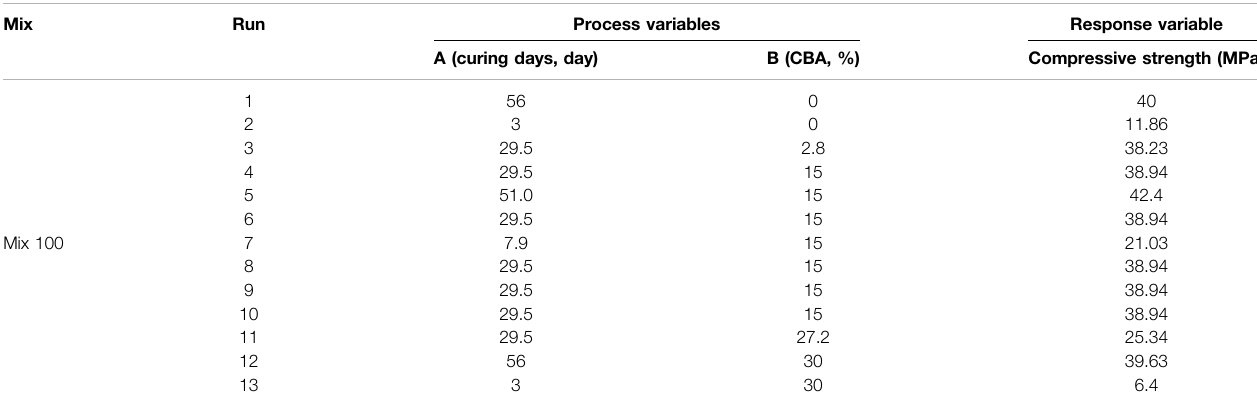
TABLE 9 | Design layout in RSM and ANOVA for Mix